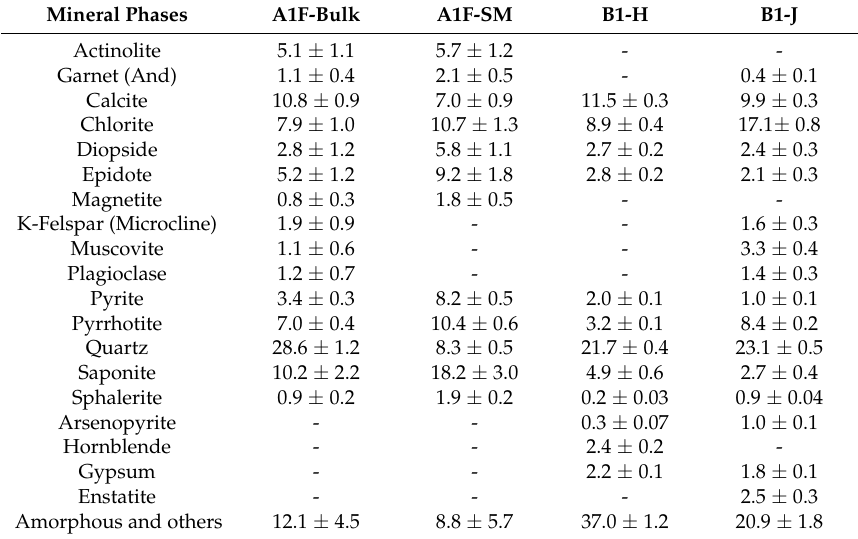
Table 3. X-ray powder diffractometric values for fractions from the old tailing in wt %.